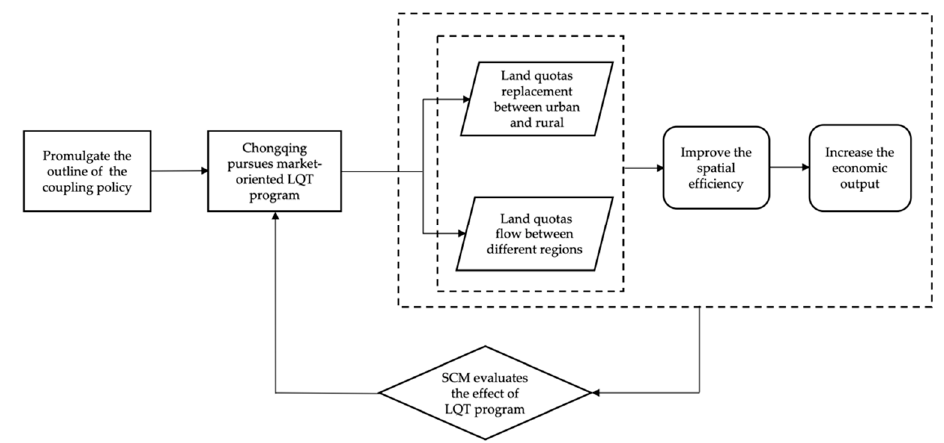
Figure 5. The framework for evaluating the effect of the LQT program.